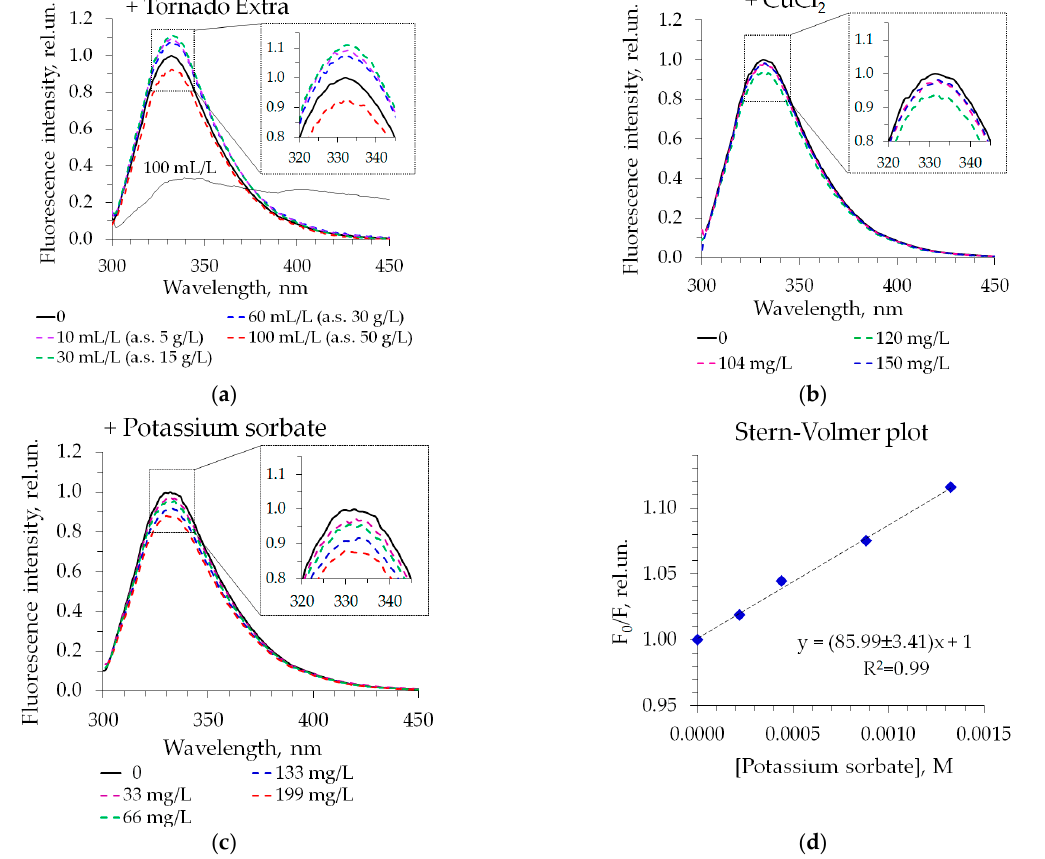
Figure 5. Fluorescence spectra of trypsin under 295-nm excitation in the presence (colored dashed lines) and in the absence (thick black lines) of additives: ( a ) Tornado Extra pesticide formulation, ( b ) CuCl 2 , ( c ) potassium sorbate. Inserts show the intensity change near the spectral maximum. Protein content was 9 U. Thin black line in panel ( a ) refers to the fluorescence spectrum of the additive without trypsin at indicated level under 295-nm excitation. Panel ( d ) shows the Stern–Volmer plot for quenching of trypsin fluorescence by potassium sorbate. Equation for the linear approximation and an adjusted coefficient of determination R 2 are indicated.